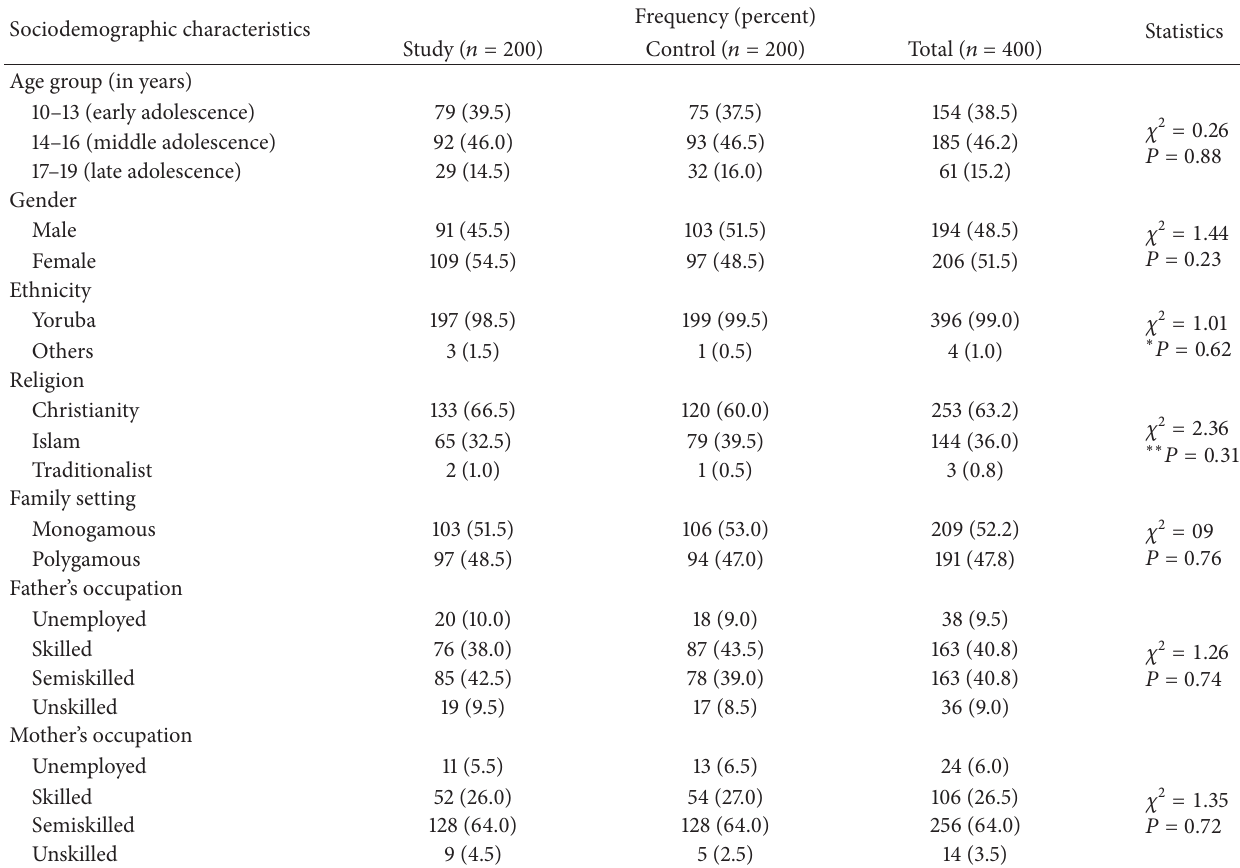
Table 1: Sociodemographic characteristics of the